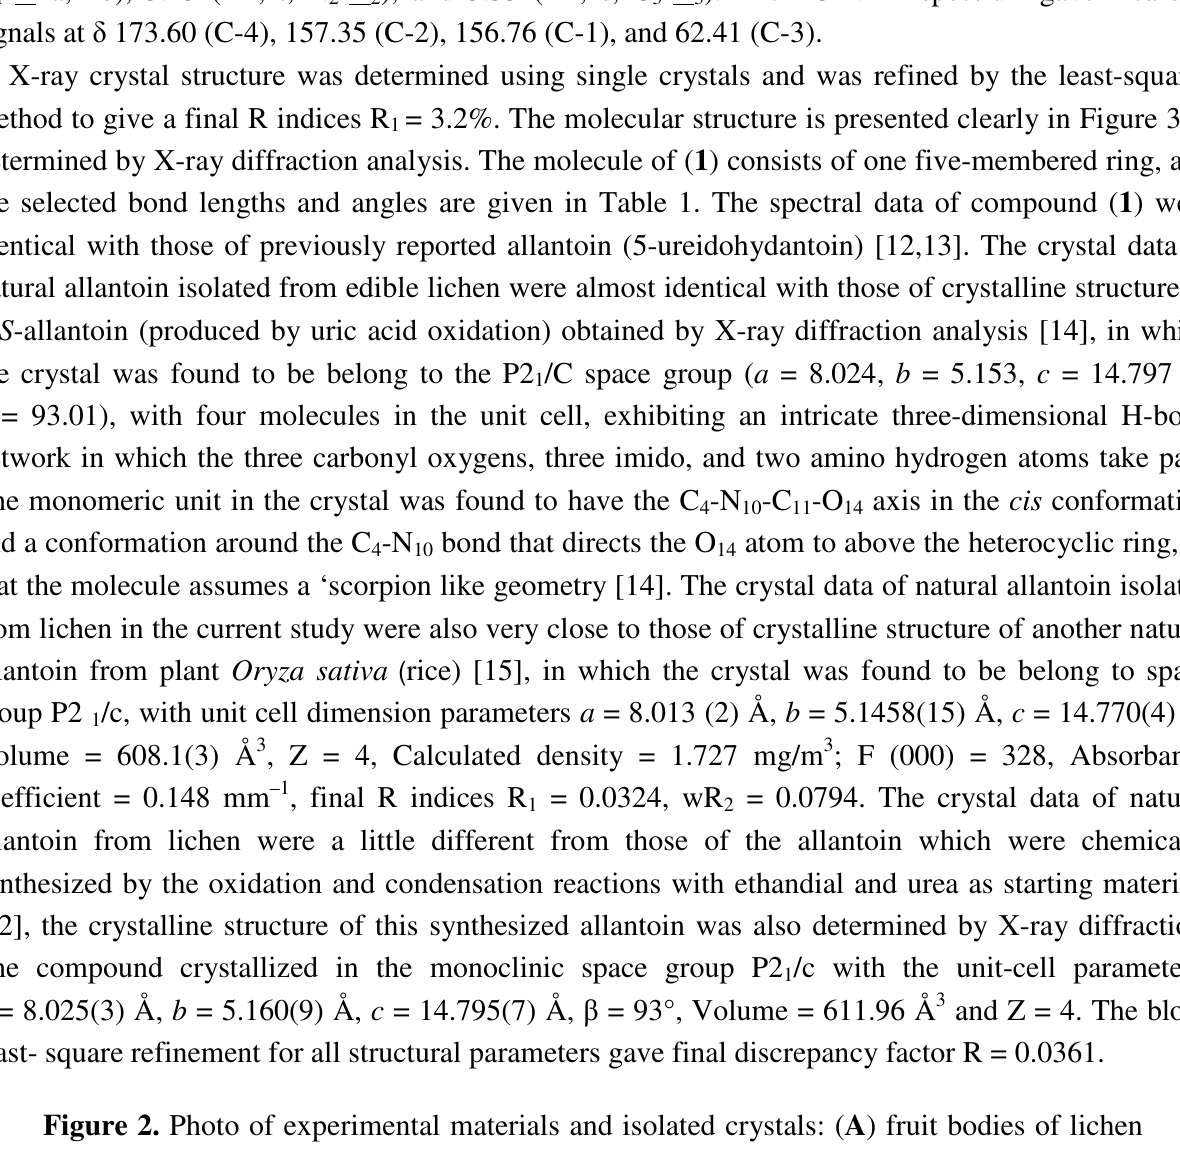
Figure 2. Photo of experimental materials and isolated crystals: ( A ) fruit bodies of lichen U. esculenta (Miyoshi) Minks; ( B ) microscopic photo of isolated crystals.